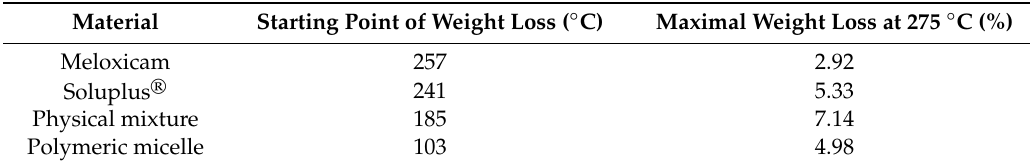
Table 5. Thermal behavior of components and the formulation.